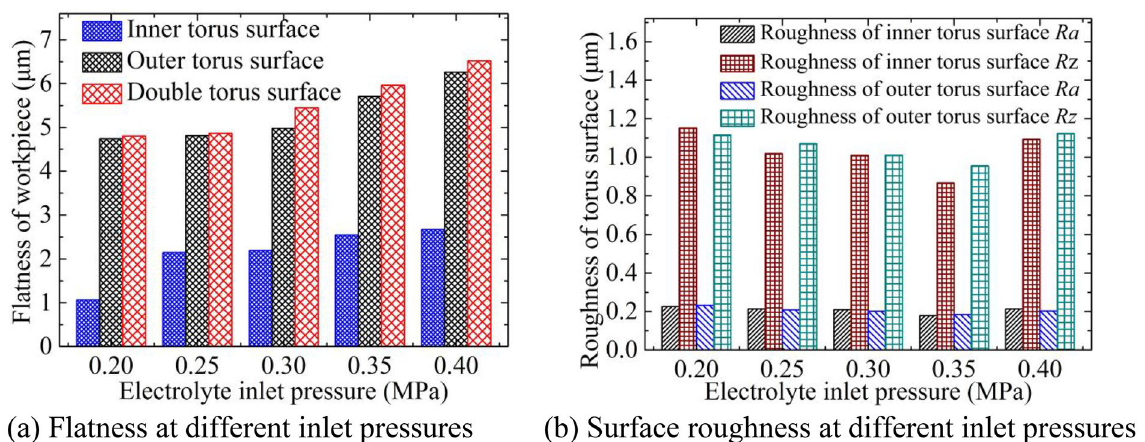
Figure 8. Flatness and roughness at different inlet